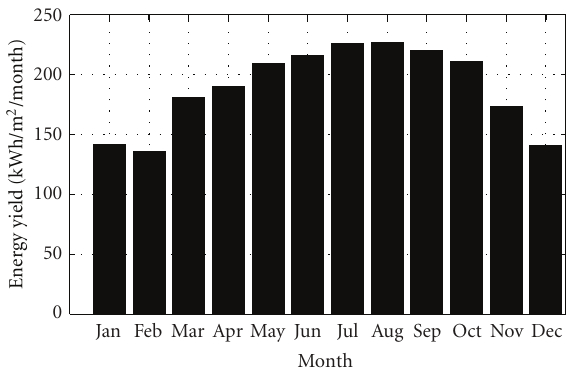
Figure 3: Energy yield of the PV systems; the energy yield is 227.1 kWh/m 2 /year.